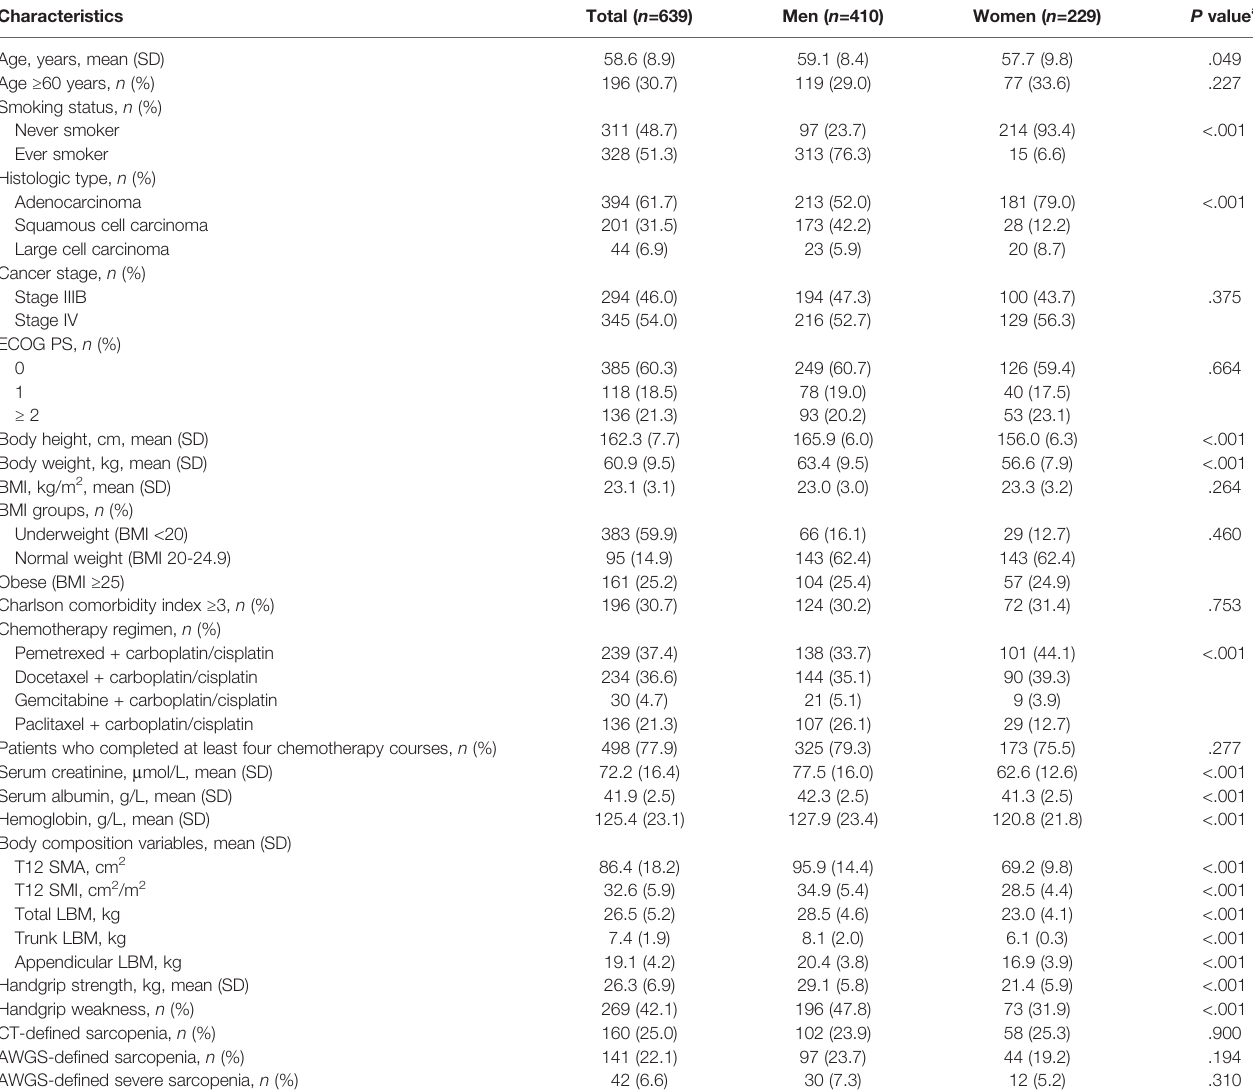
TABLE 1 | Baseline characteristics of the study population according to sex.